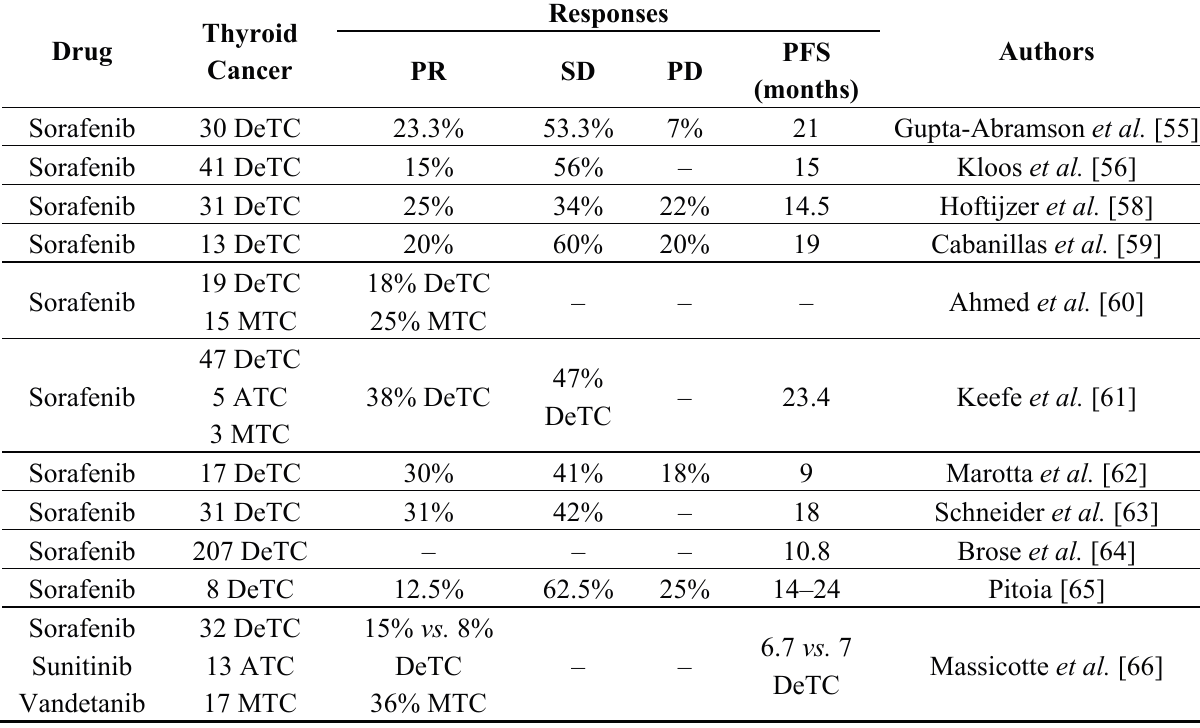
Table 1. Clinical trials of Sorafenib in patients with thyroid